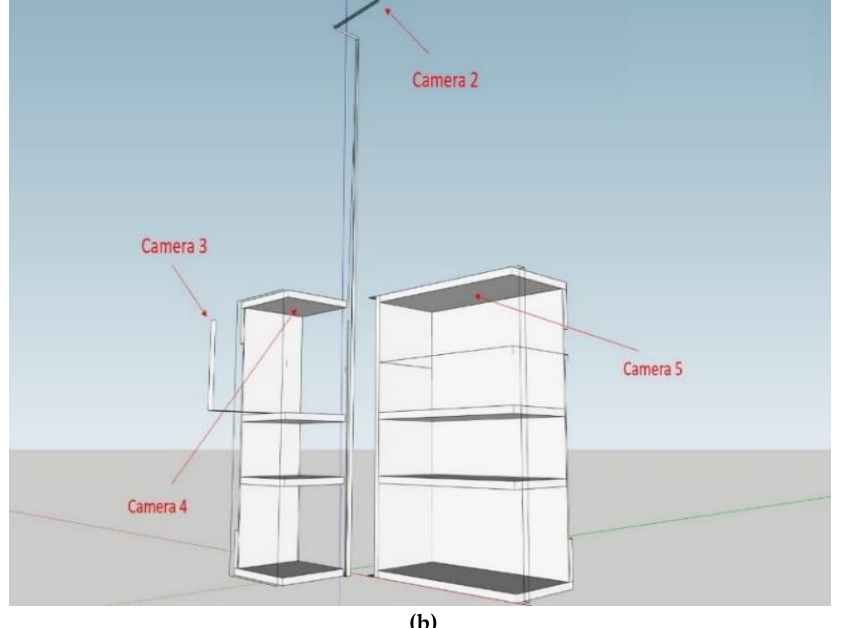
Figure 2. Hardware architecture: ( a ) Camera 1 is located in the entrance/exit; ( b ) the locations of the rest of the four cameras are inside the store.